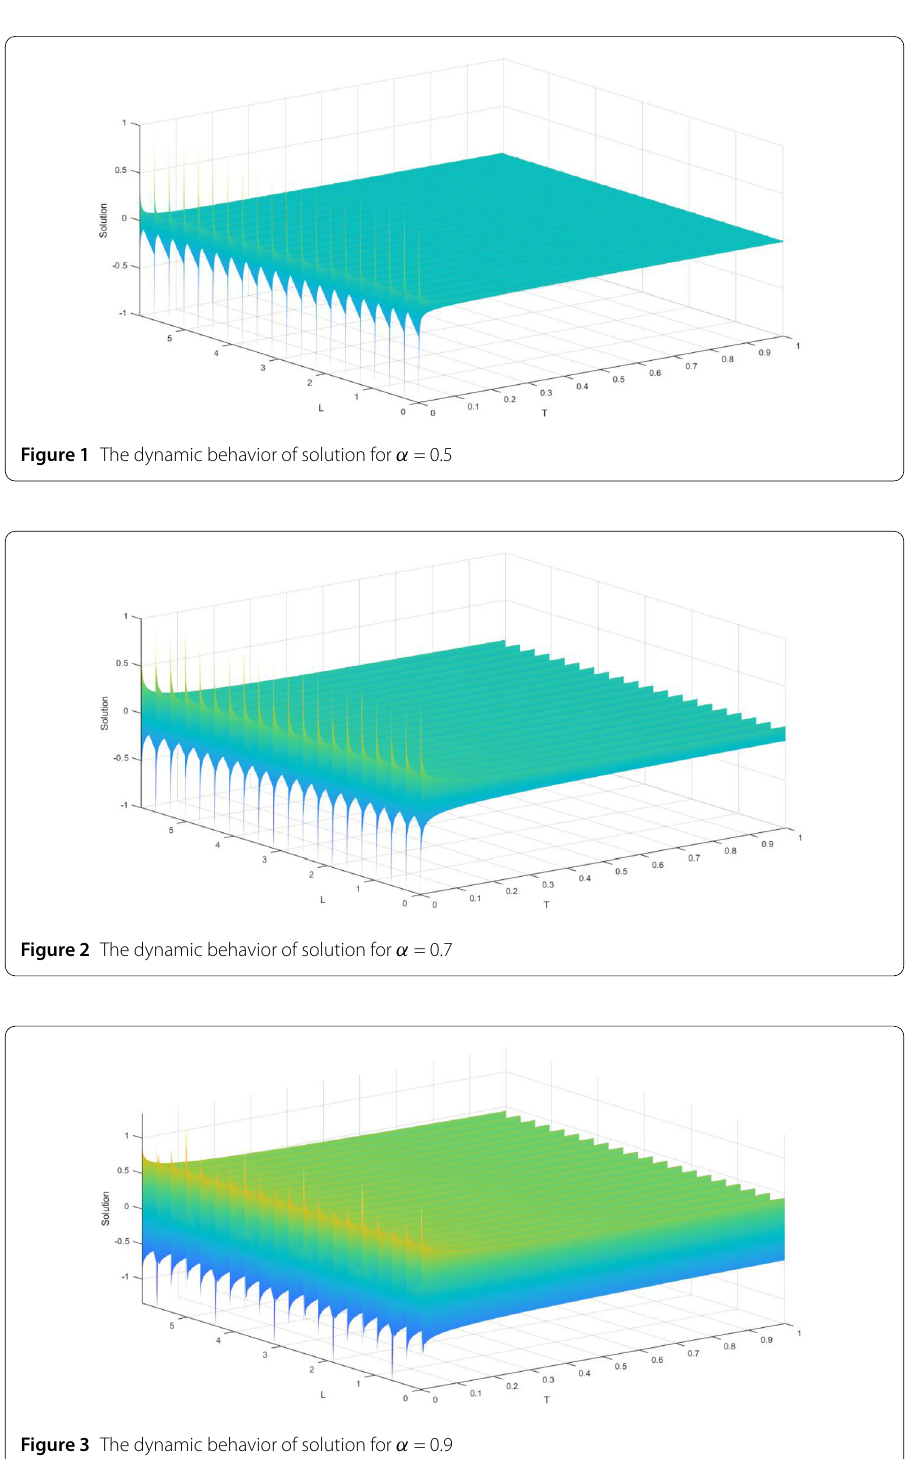
Figure 3 The dynamic behavior of solution for α =